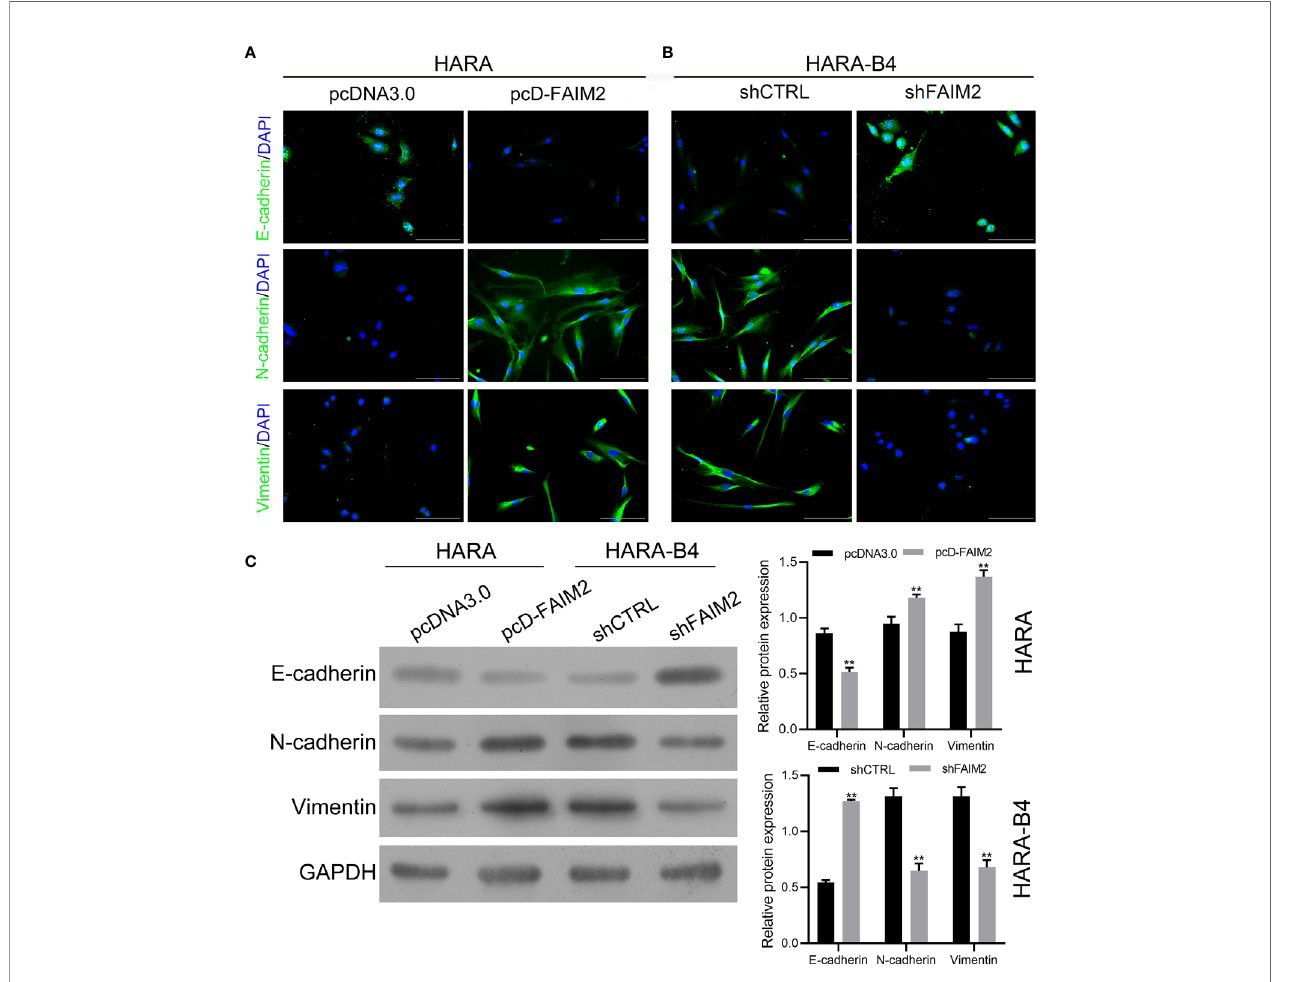
FIGURE 6 | FAIM2 facilitated bone metastasis by regulating the EMT processes. Following pcDNA3.0 or pcD-FAIM2 transfection of HARA cells, as well as shCTRL or shFAIM2 transfection of HARA-B4 cells, (A, B) the expression of EMT markers, including E-cadherin, N-cadherin, and Vimentin was examined by immuno fl uorescence staining. (C) The levels of E-cadherin, N-cadherin, and Vimentin protein expression were determined by Western blotting. P < 0.01, ** vs. the pcDNA3.0